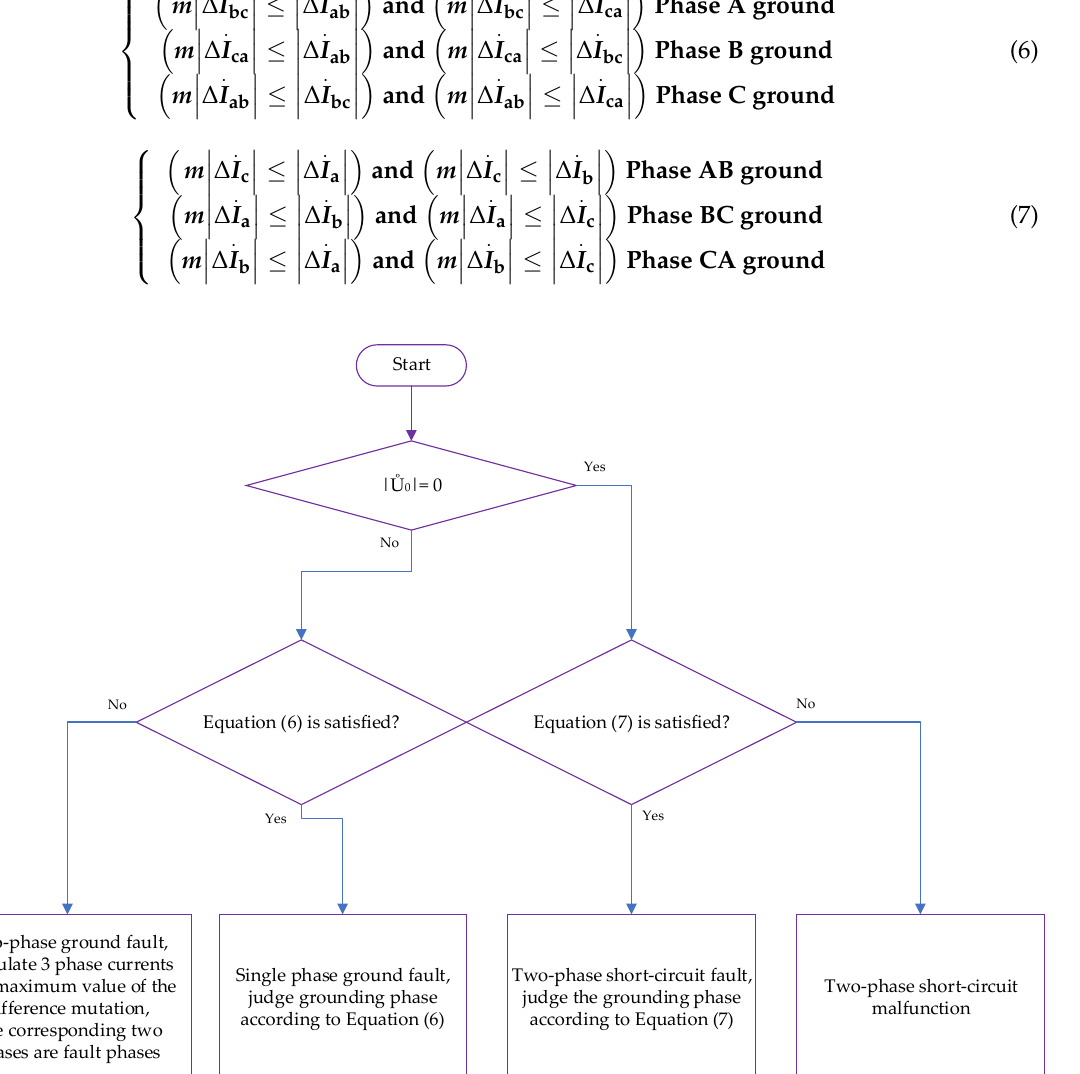
Figure 2. The proposed mechanism flowchart.